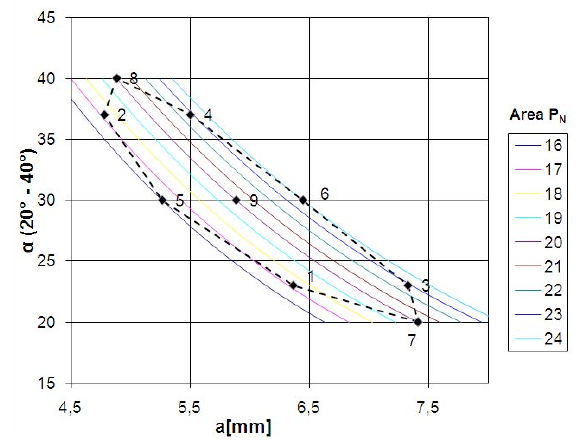
Fig. 29. DOE bevel edge proposal